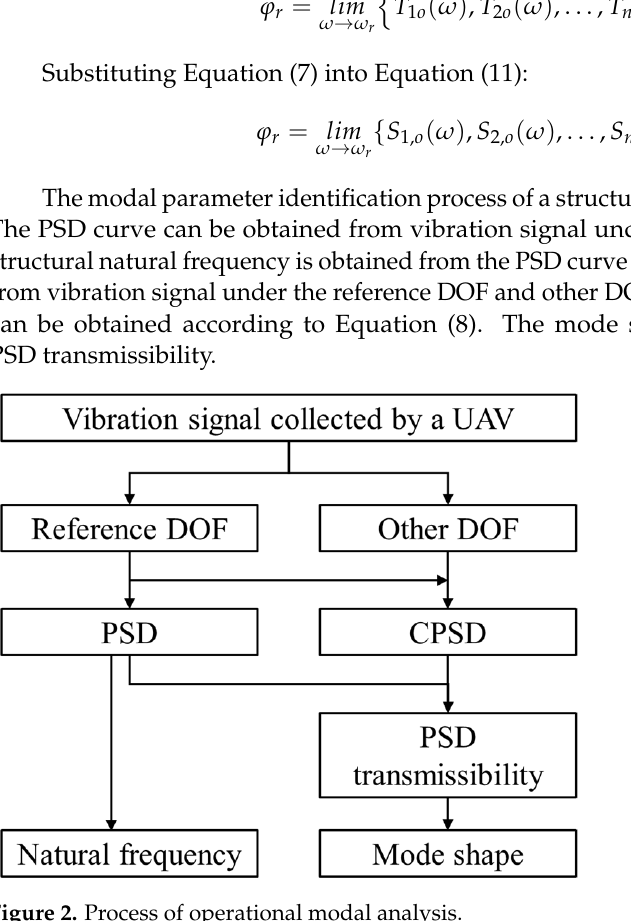
Figure 2. Process of operational modal analysis.